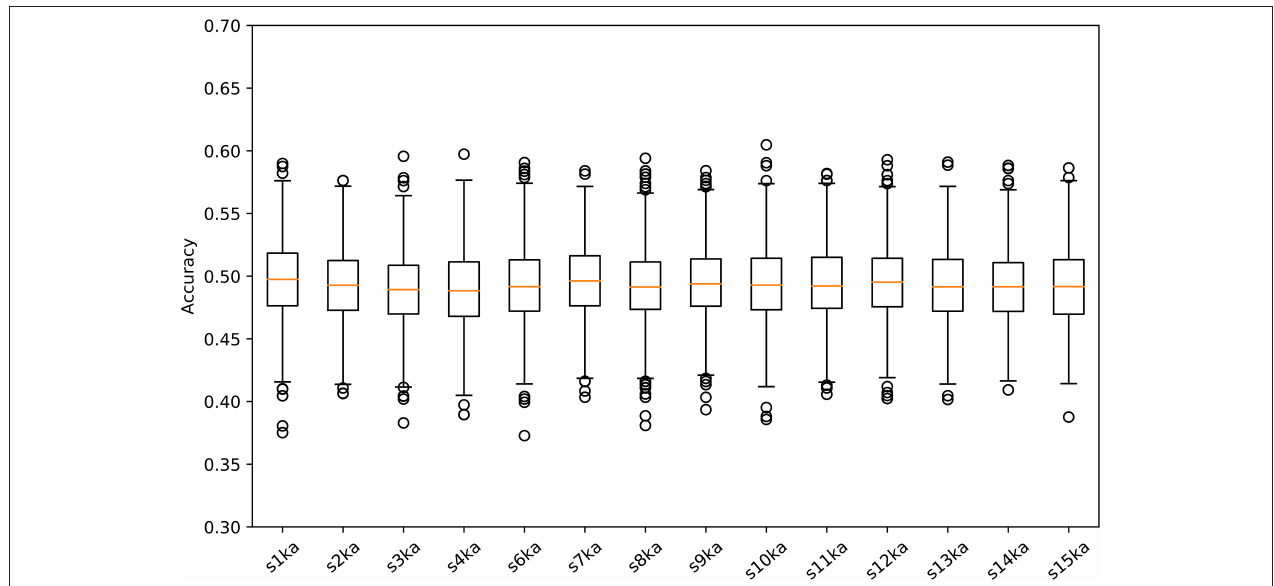
FIGURE 3 | Box plots of the classification accuracies for the randomly shuffled